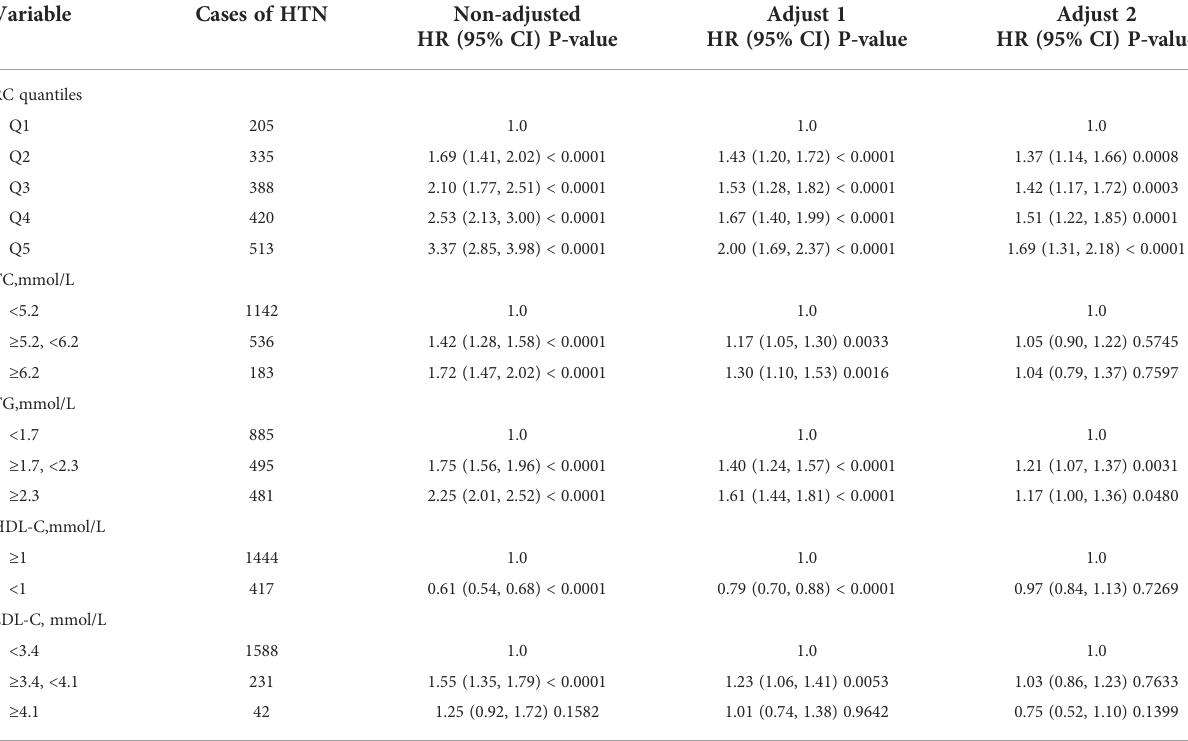
TABLE 2 Association of RC, lipid parameters with HTN